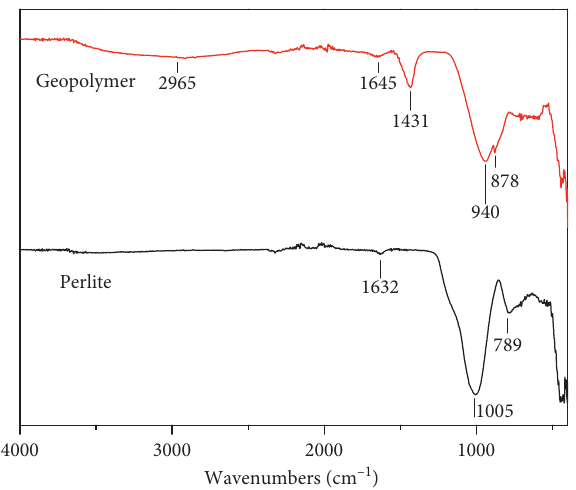
Figure 2: FT-IR analysis of perlite and geopolymer.